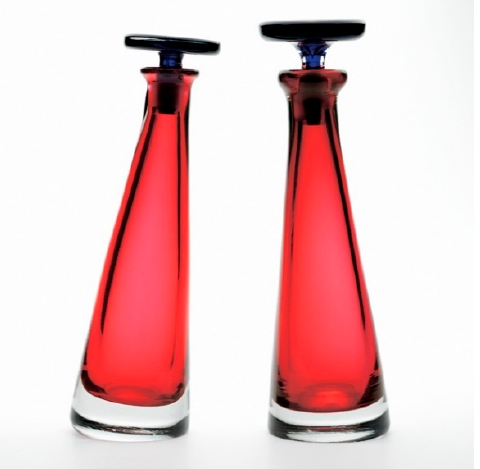
Figure 4. Maria Helena Matos, Fábrica Escola Irmãos Stephens (F.E.I.S), 1960. Photo credit: Arquivo do Museu do Vidro—Câmara Municipal da Marinha Grande.